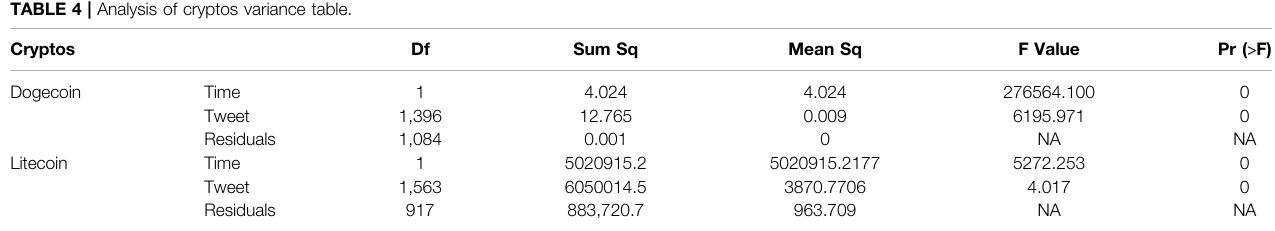
TABLE 4 | Analysis of cryptos variance table.